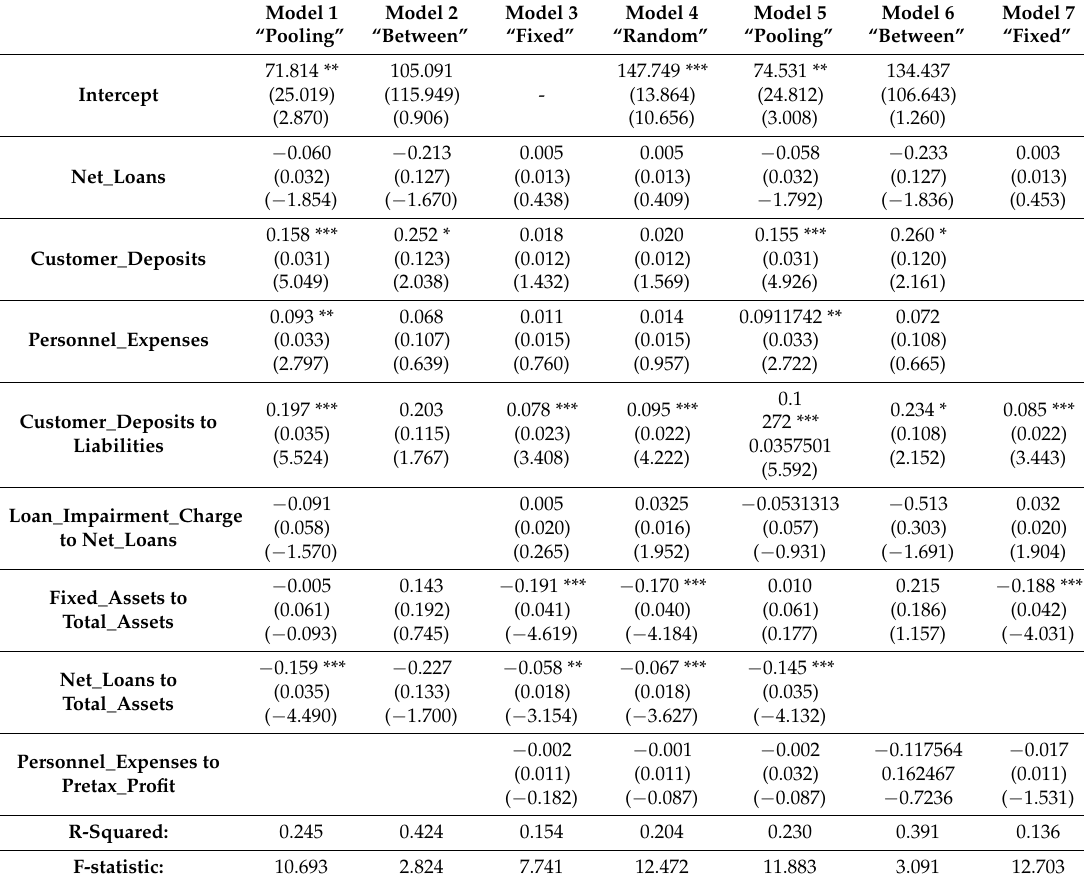
Table 10. Results of panel regression model for the Central and Eastern Europe